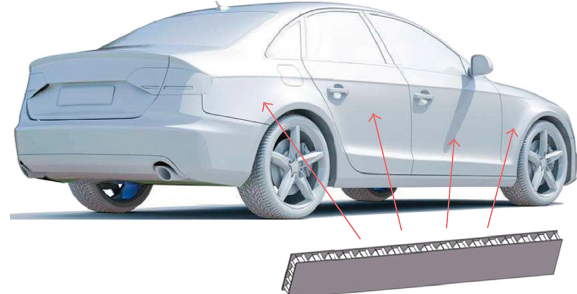
Figure 3: Schematic of finite element model.